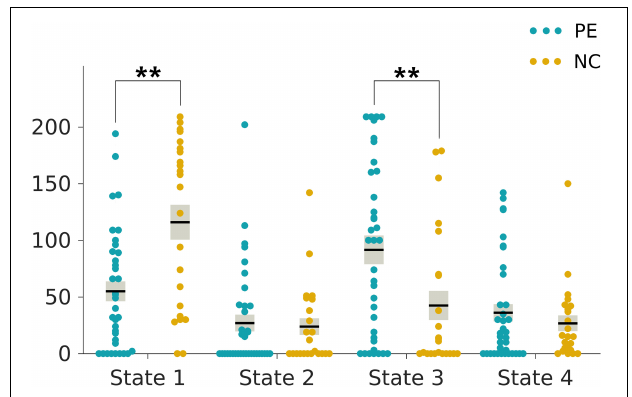
FIGURE 4 | Group differences in the transition frequencies between the dynamic functional connectivity states. The ticks on the horizontal axis indicate the state transition pairs, e.g., “1–2” refers to the transitions between state 1 and state 2. The state transition times of each individual in the lifelong premature ejaculation (LPE) and normal control (NC) groups are presented in blue and khaki, respectively. For each group, the black line indicates the mean state transition times in that group, and the light gray rectangle covers the data within one standard error above and below the mean. The pairs of groups with asterisks indicate significant differences between them: * p < 0.05, uncorrected.